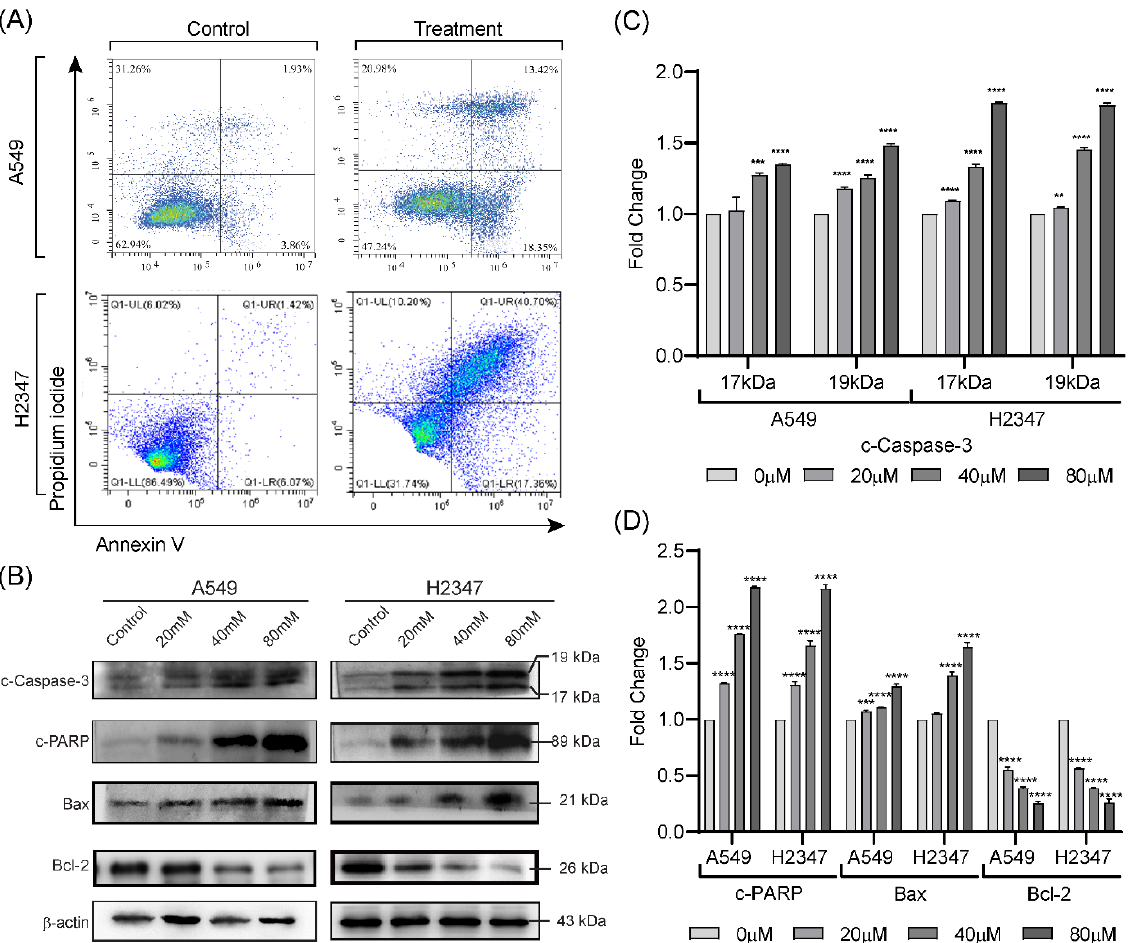
Figure 3. Effect of Lactucin on apoptosis induction of lung cancer cells. Lactucin and equivalent volume of the vehicle (DMSO) exposure (24 h) induced apoptosis of lung adenocarcinoma A549 (80 µ M) and H2347 (70 µ M) cells ( A ) were measured by flow cytometry. WB analysis of c-Caspase-3, c-PARP, Bax, and Bcl-2 protein expression was performed after A549 and H2347 cells were exposure to Lactucin at 0, 20, 40, and 80 µ M for 24 h ( B – D ). Data are expressed as the means ± standard deviation of triplicate experiments. ** p < 0.01, *** p < 0.001, and **** p < 0.0001 indicate result ’ s significant difference from the control.